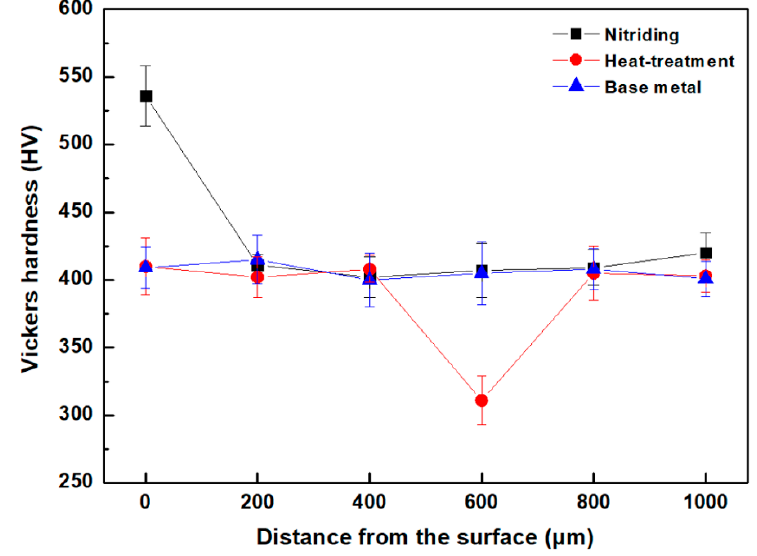
Figure 9. Vickers hardness of the BM, LH P21, and LN P21 as a function of the depth from the